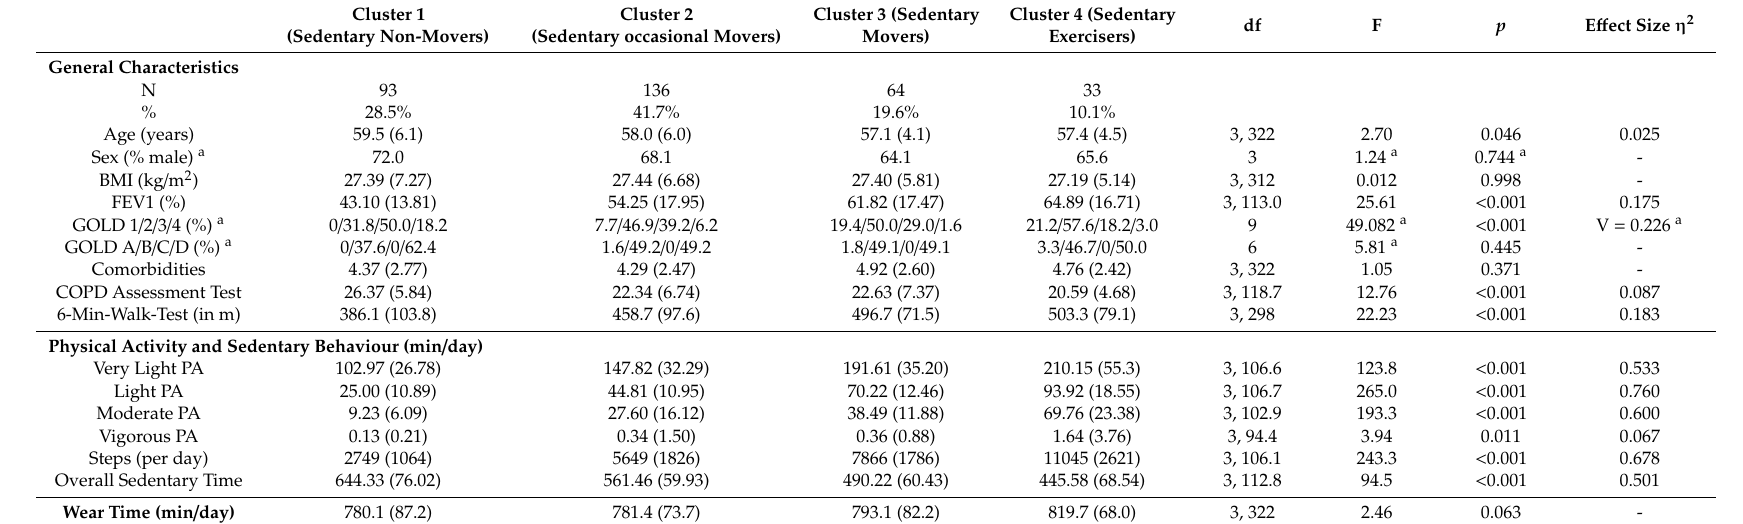
Table 2. Characteristics of the four